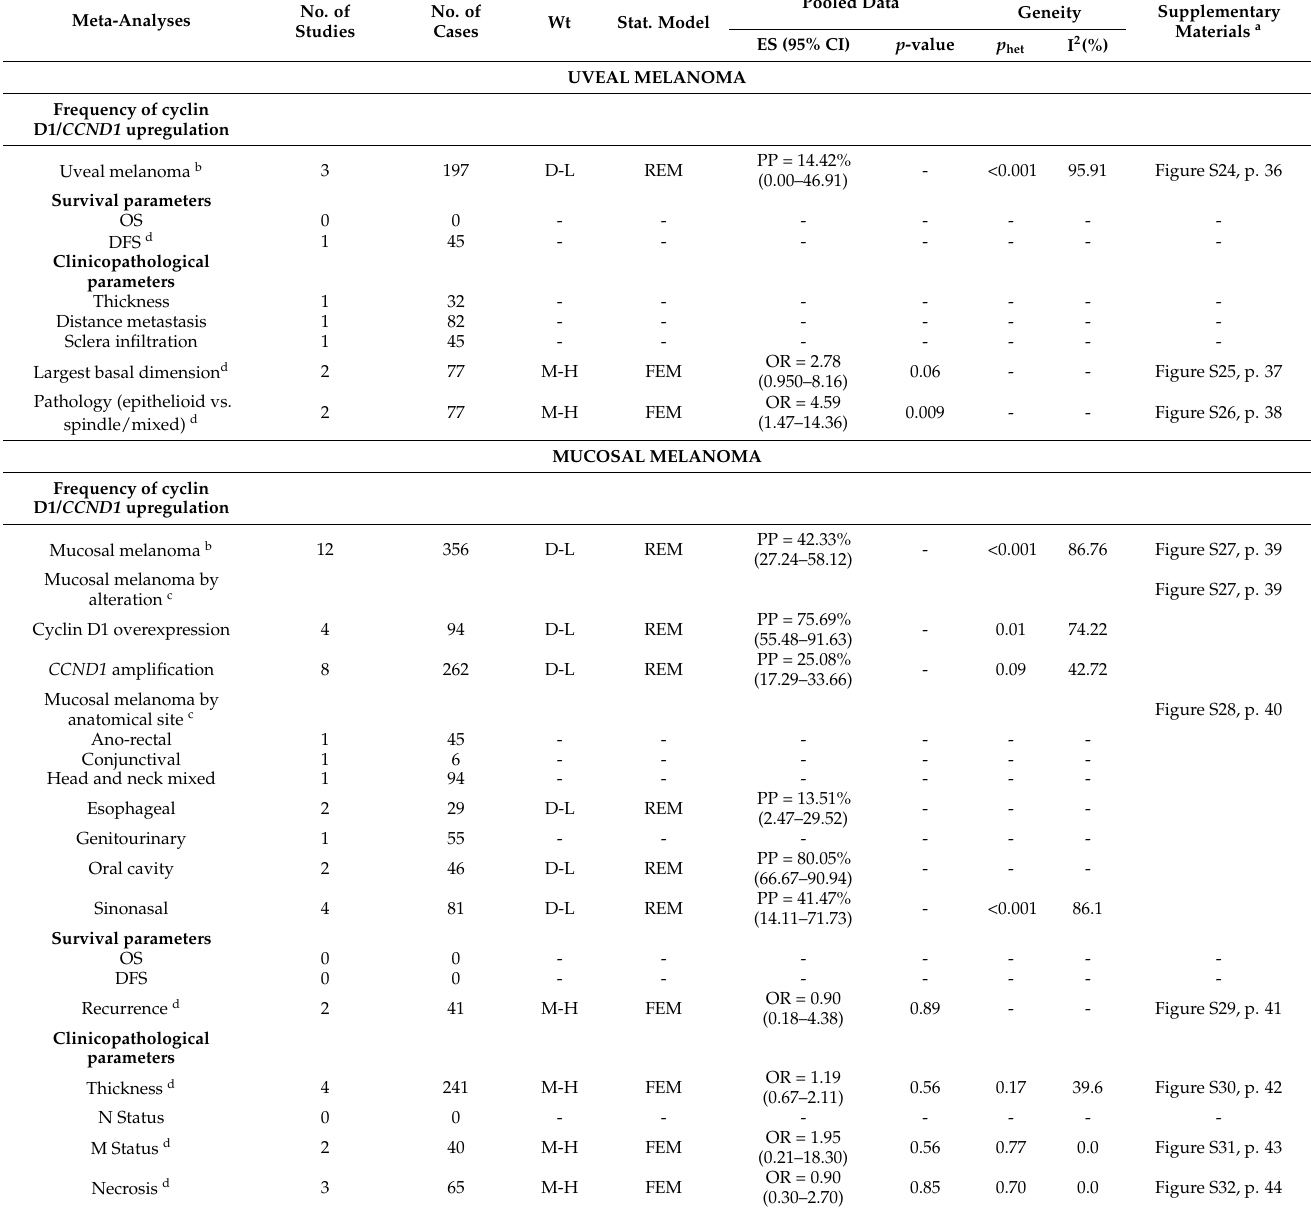
Figure S30, p. 42 Figure S31, p. 43 Figure S32, p.